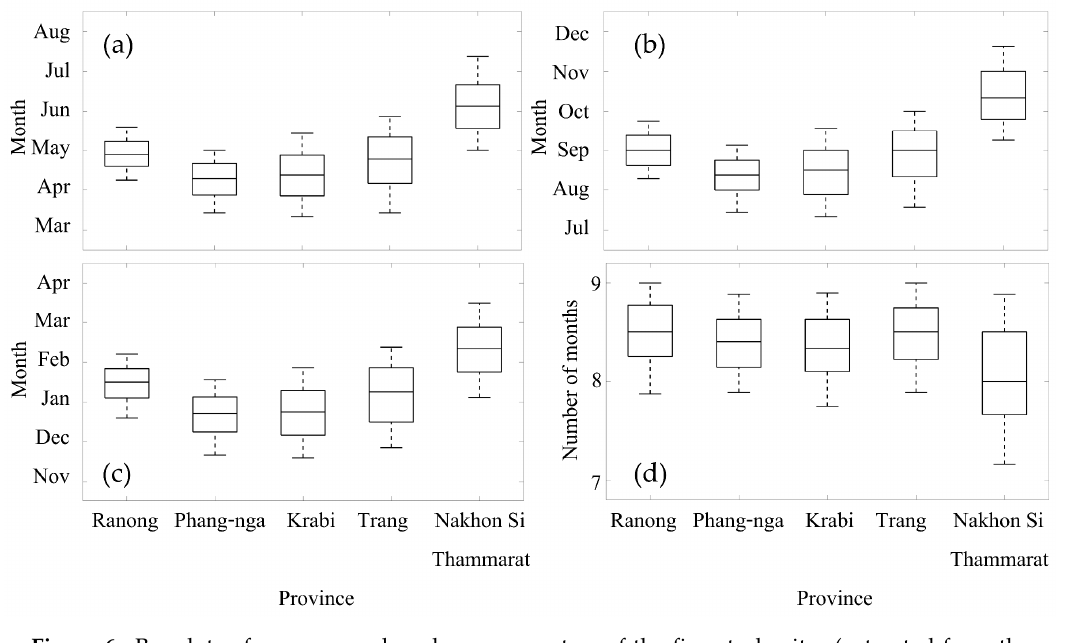
Figure 6. Boxplots of mangrove phenology parameters of the five study sites (extracted from the mangrove areas in Figure 5), ( a ) SOS, (b) POS, ( c ) EOS and ( d ) LOS. The Andaman Sea sites are Ranong, Phang-nga, Krabi and Trang province, sorted from North to South (left to right) and the Gulf of Thailand site is Nakhon Si Thammarat province.